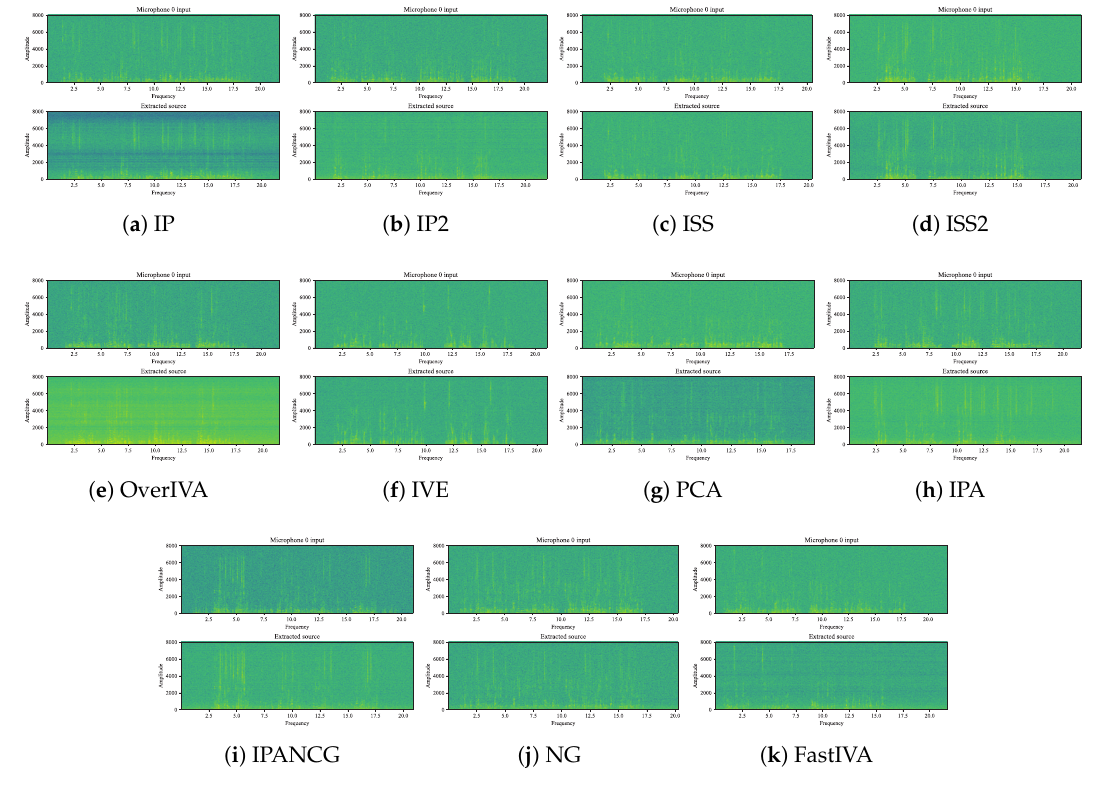
Figure 14. Separation effect